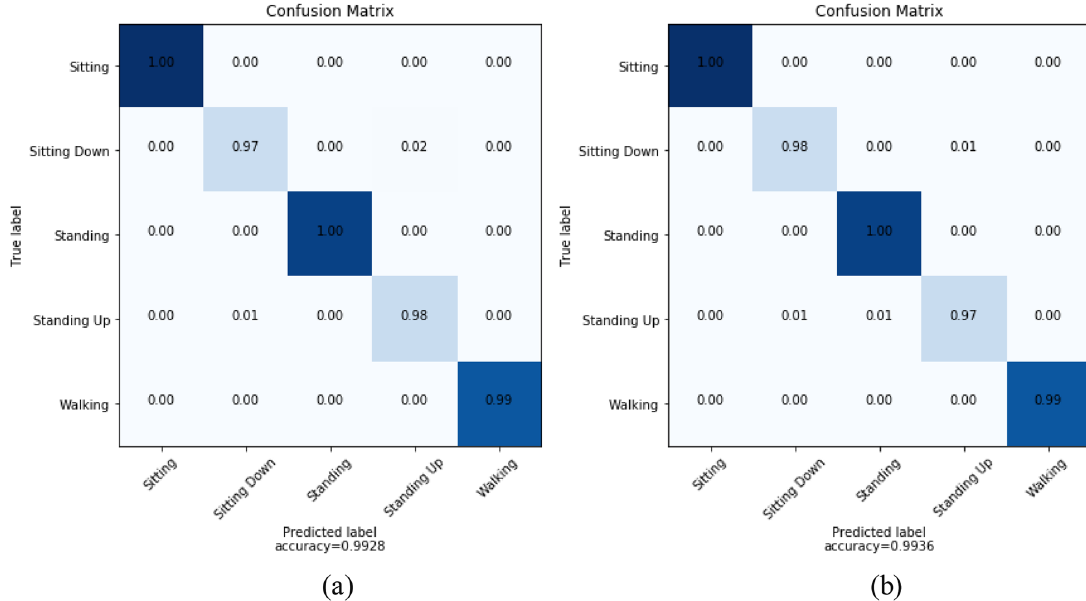
Figure 13. NSL-model performance on (a) fold-1 and (b) fold-2 of PUC-Rio dataset.